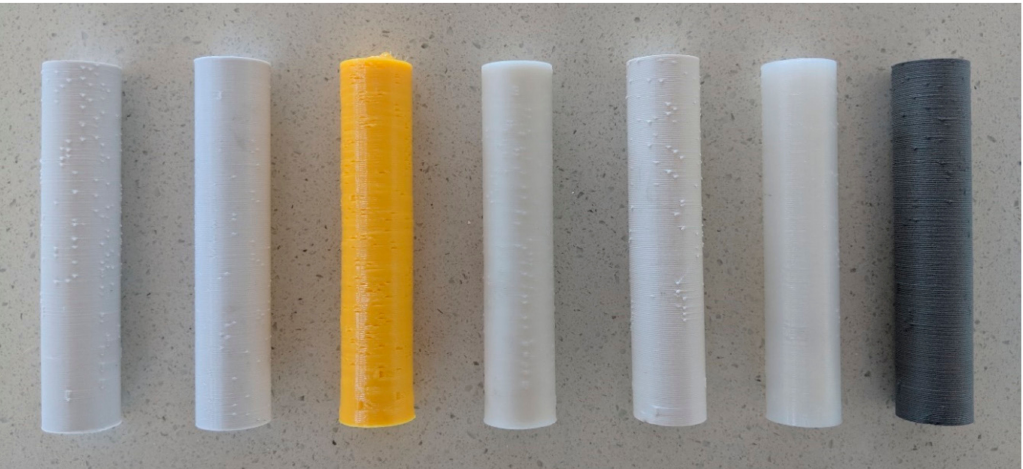
Figure 2. Small-scale fuel grains, left to right: ABS, PLA, PETG (Polyethylene terephthalate glycol), PP, ASA, Nylon, and AL (PLA with aluminum